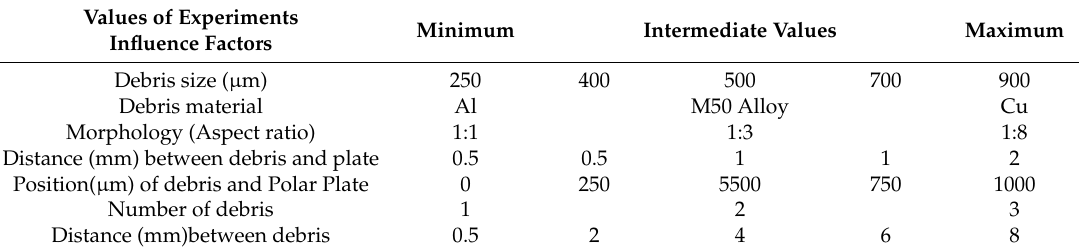
Table 2. Influence factors and experimental values of